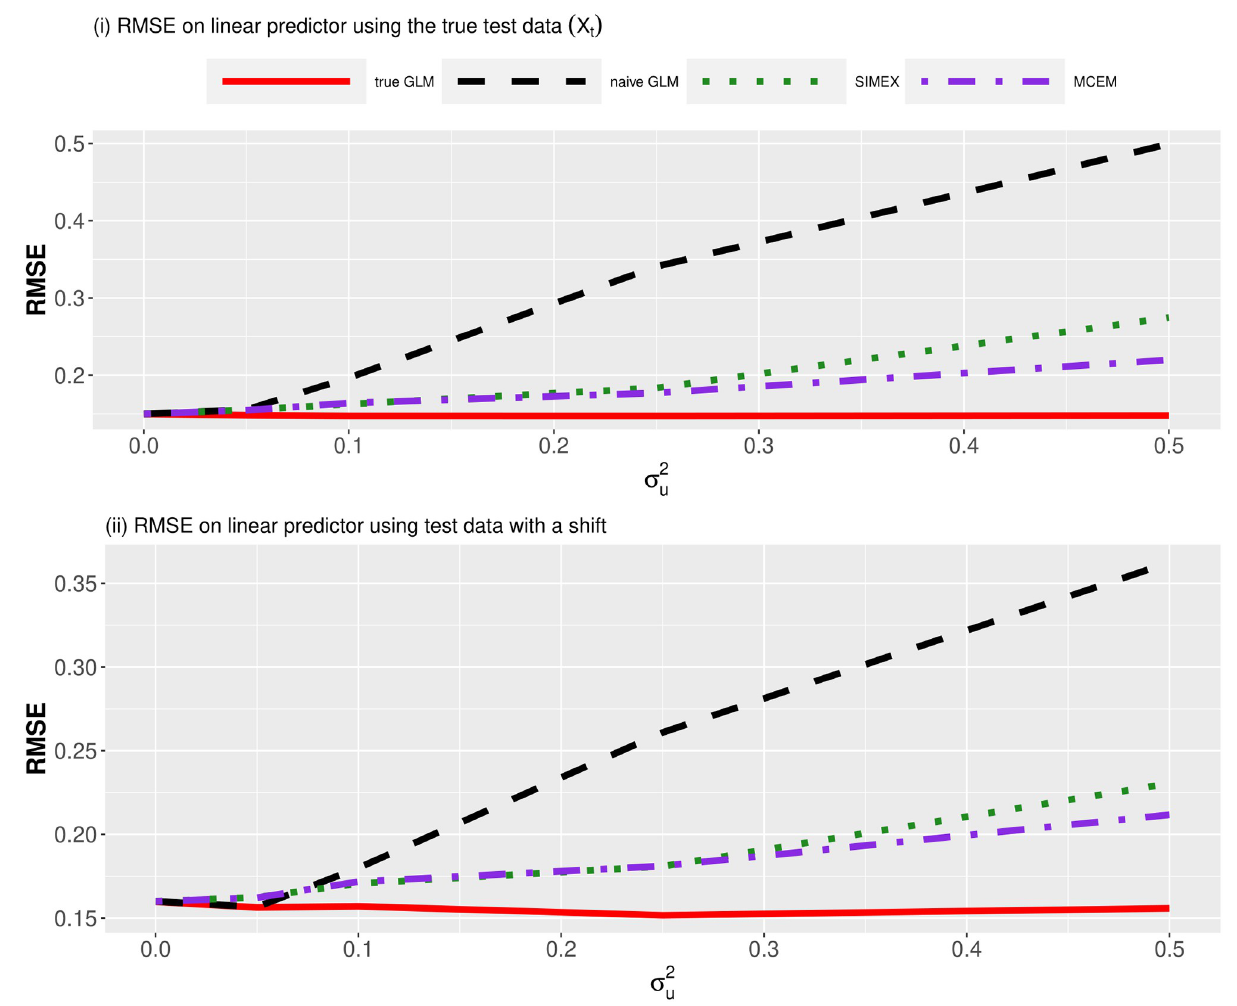
Fig 2. RMSE on the test data when fitting (logistic) quadratic models to binary data across increasing measurement error values σ 2 considered two cases: (i) independent test data and (ii) independent test data with an increased shift of 0.5 units in X i . We fitted the same models as in Simulation 1. For both cases, we see that both MCEM and SIMEX give better predictions compared with the na ï ve